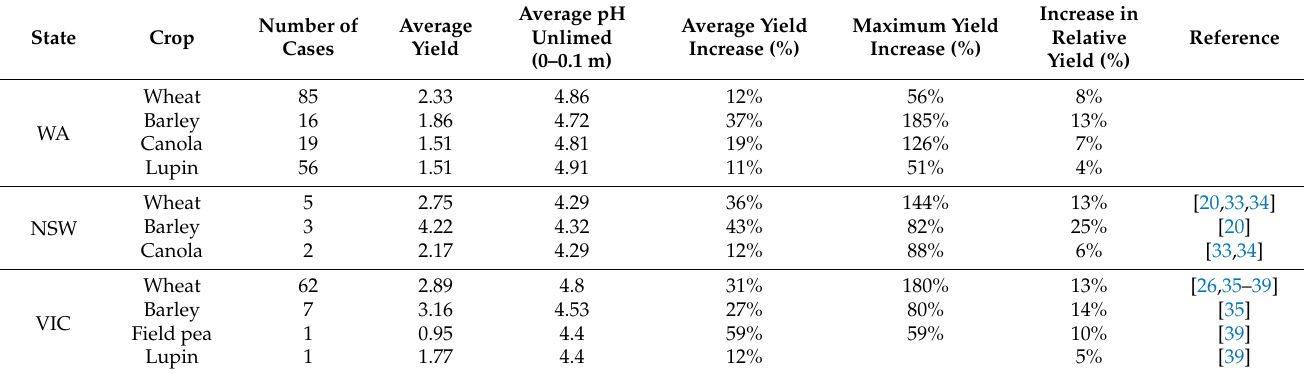
Table 1. Australian lime trial data from WA, NSW and Victoria arranged by crop type showing the number of cases (N), average yield, average pH in the unlimed treatment, average yield increase, maximum yield increase and increase in relative yield (one year after lime was applied). The references for the data from NSW and VIC are noted in the last column. State